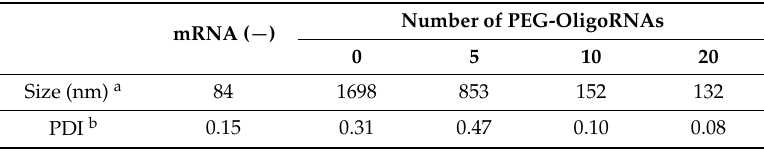
Figure 6. Characterization of DOTAP/Chol LNPs loaded with PEG-OligoRNAs/mRNA. ( a ) Gel electrophoresis of unhybridized mRNA and mRNA hybridized with 5, 10, or 20 PEG-OligoRNAs, in a naked form or after complexation with DOTAP/Chol liposomes. ( b ) The sizes and ( c ) ζ -potential of the DOTAP/Chol LNPs without mRNA addition (mRNA ( − )), and that loading mRNA hybridized with 0, 5, 10, or 20 PEG-OligoRNAs were measured. n = 6 for ( c ). Data are presented as mean ± standard error of the mean. Table 3. Dynamic light scattering measurement of DOTAP/Chol LNPs.